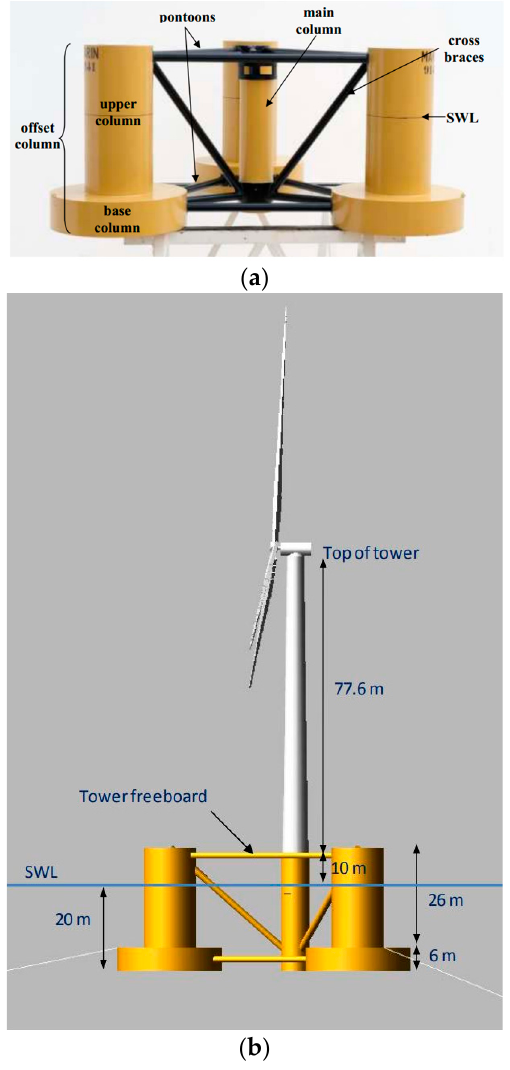
Figure 1. Definition of the semi-submersible floating offshore wind system [12]: ( a ) OC4 DeepCwind semi-submersible platform; ( b ) NREL 5 MW semi-submersible floating offshore wind turbine.